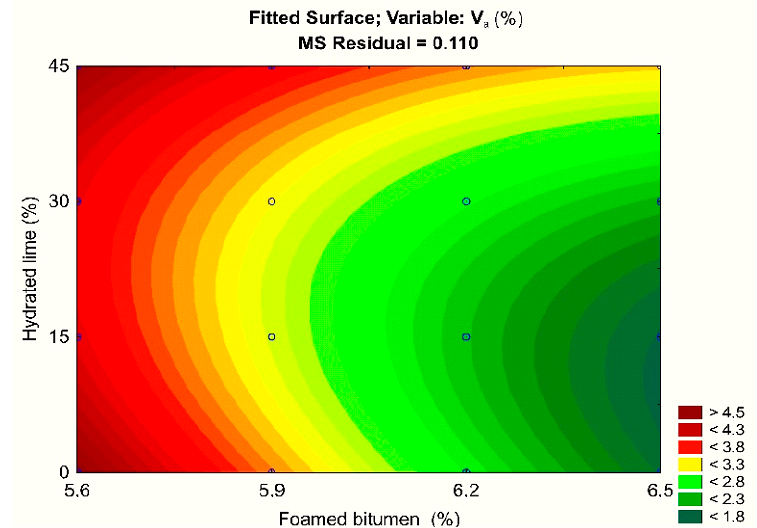
Figure 6. Air void content (V a ) of AC 8 S as a function of the quantity of foamed bitumen and hydrated lime; the model describing these relationships V a = 68.158 − 18.425FB + 1.266FB 2 − 0.276HL + 0.001HL 2 + 0.038FB·HL [74].